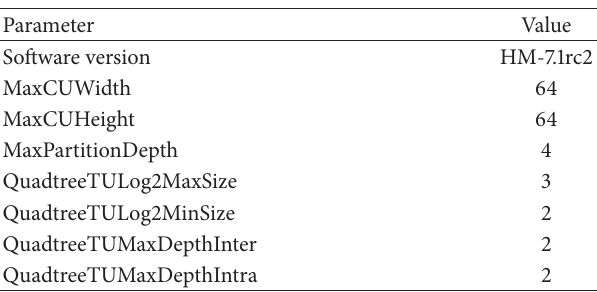
Table 3: Configuration